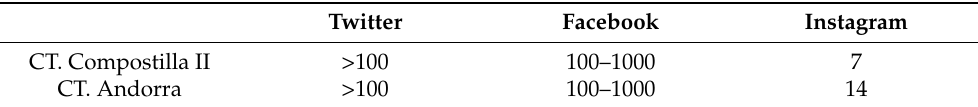
Table 7. Comparison of results between 2 ENEL-ENDESA thermal power plants subject to citizen- driven heritage processes.